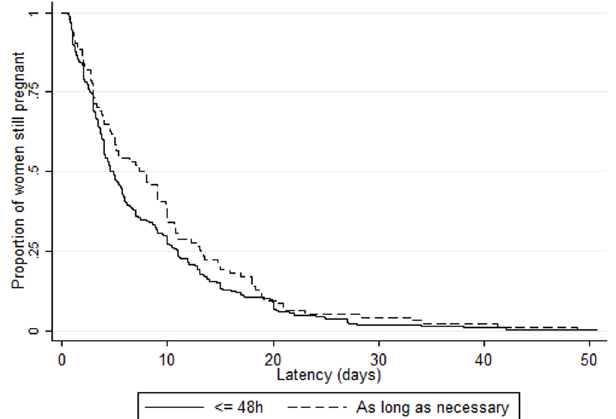
Figure 4. Kaplan Meier survival curves of latency duration by duration of tocolytics use, in units with a liberal policy of tocolysis after PPROM. There was no difference in Kaplan-Meier curves of latency duration by duration of tocolytics use (logrank test p = 0.13) in units with a liberal policy of tocolysis after